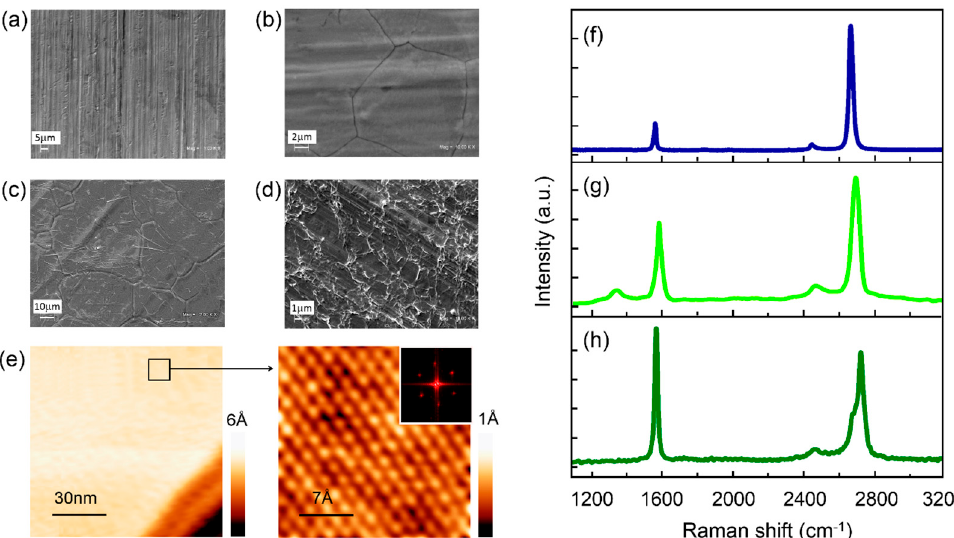
Figure 1. Structural and morphological characterization of samples. SEM images of ( a ) NiF; ( b ) NiT; ( c ) FLG on Ni; ( d ) 4MLG on Ni; ( e ) Large-scale STM topography (100 × 100 nm 2 ) of few-layers graphene grown on Ni (I = 0.7 nA, V BIAS = 0.1 V). High-magnification STM image (2.5 × 2.5 nm 2 ) showing the triangular lattice atomic structure of few-layer graphene on Ni with lattice constant 2.4 Å, according to Fourier transform analysis (inset). Representative Raman spectra of SLG grown on Cu (for reference) ( f ), 4MLG tranferred on Ni ( g ) and FLG grown on Ni ( h ). Background caused by the luminescence of the copper was subtracted in the case of SLG grown and transferred on Cu.